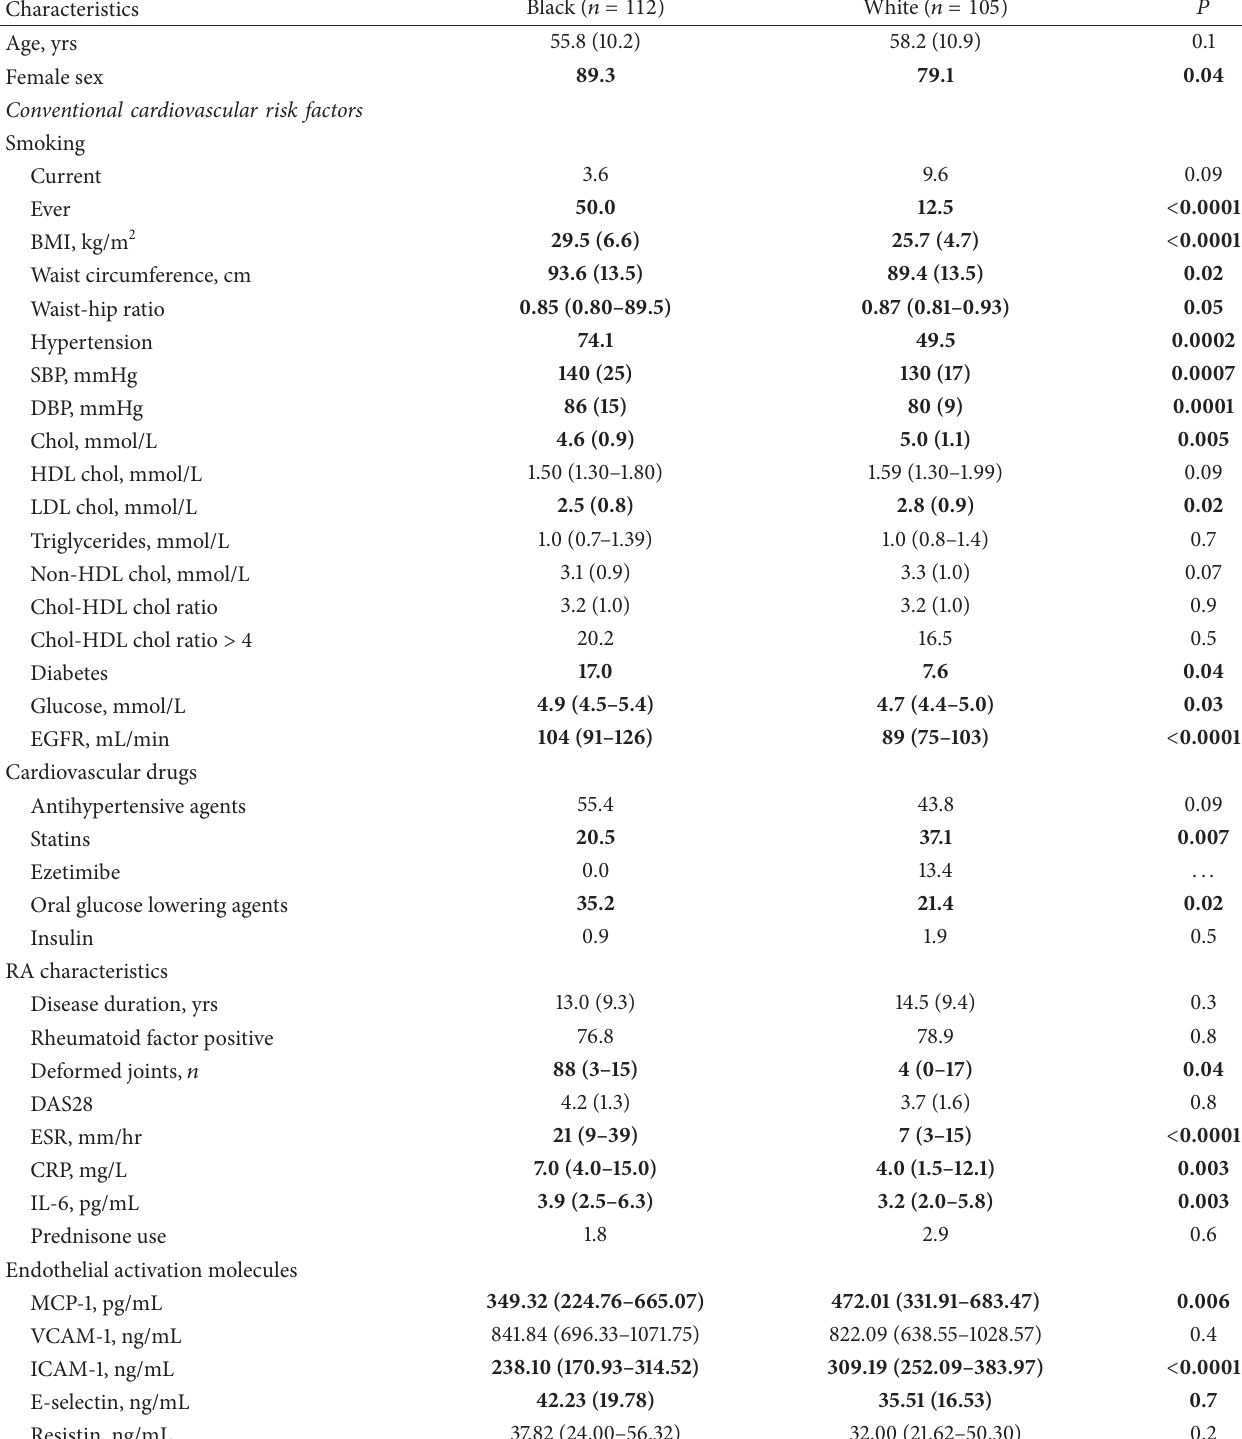
Table 1: Clinical characteristics and endothelial activation molecule and resistin concentrations in black and white patients with RA.